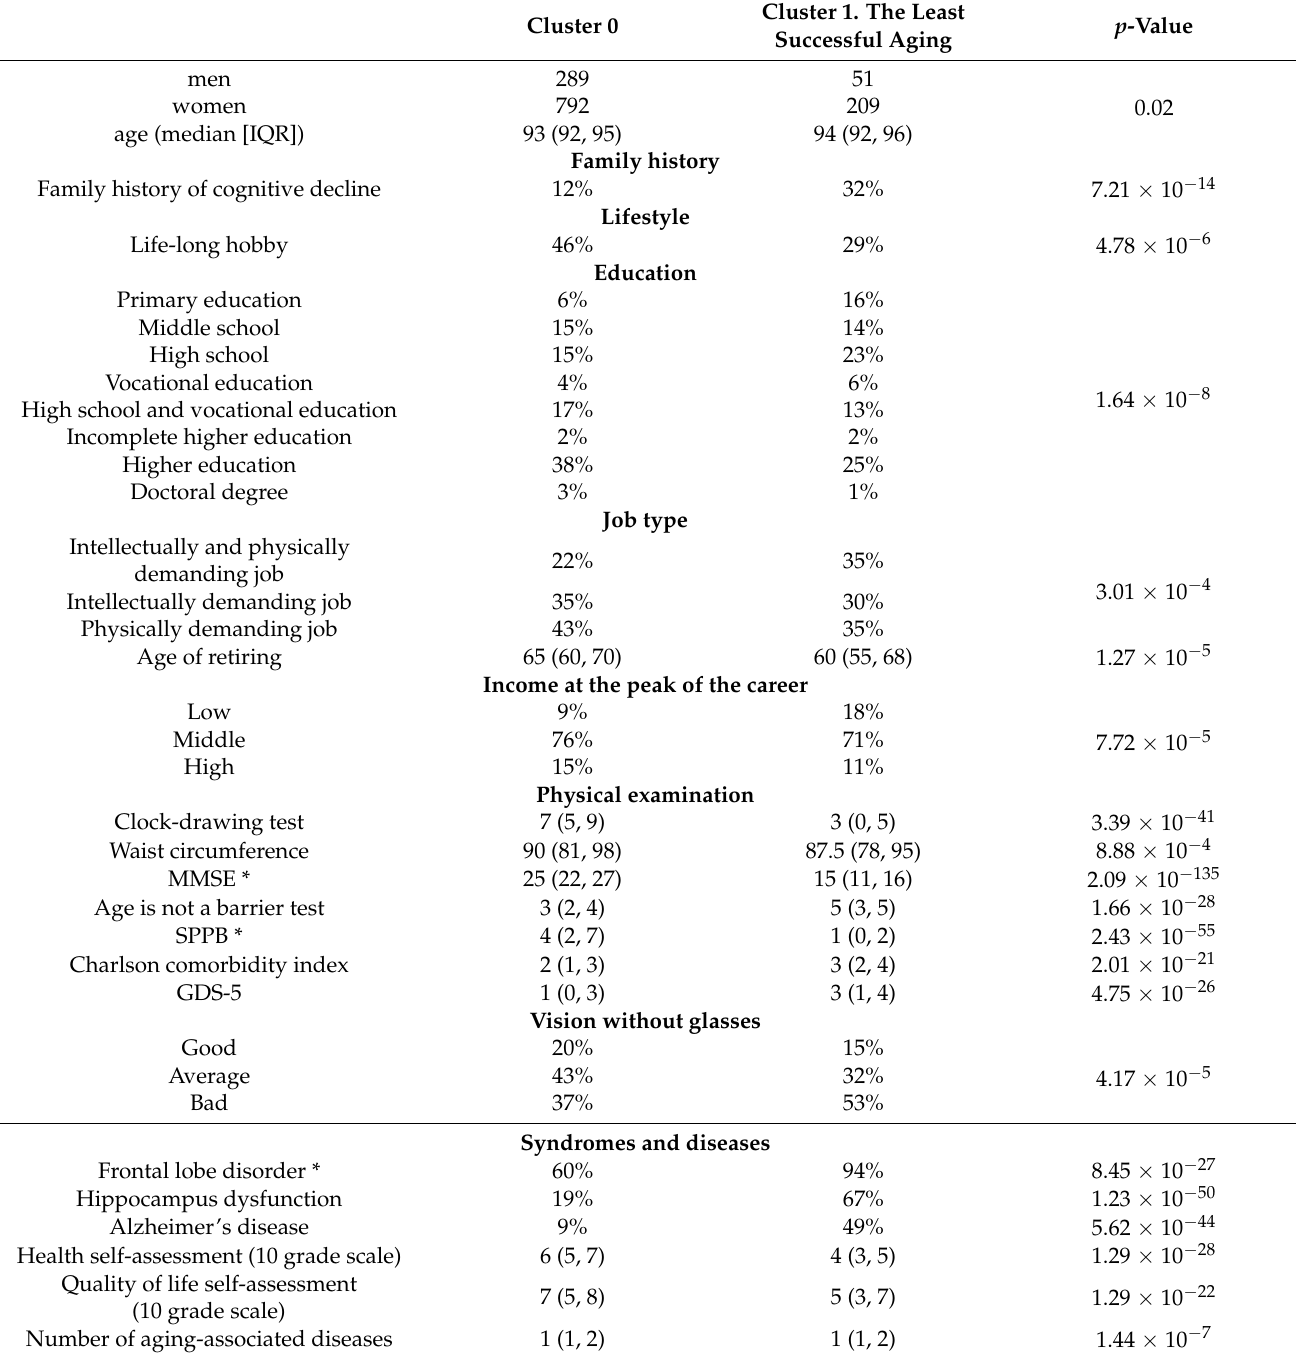
Table 5. Differences in the factors (only significant) in the least successful aging